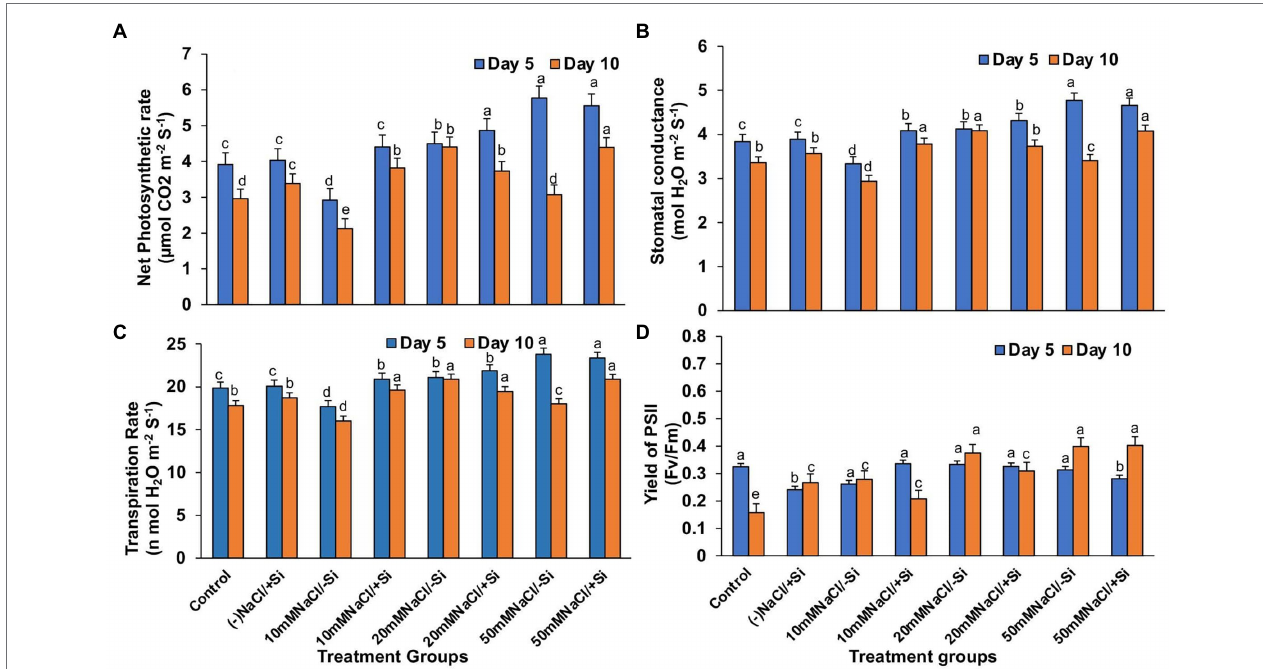
FIGURE 4 | Changes in (A) net photosynthesis, (B) stomatal conductance, (C) transpiration rate, and (D) PSII quantum yield of mung bean ( Vigna radiata ) under 1 mM (Si 1 ) Si supply and salinity stress after eight treatments: (i) control (T1), (ii) − NaCl+Si (1 mM) (T2), (iii) 10 mM NaCl/ − Si (T3), (iv) 10 mM NaCl/+ Si (1 mM) (T4), (v) 20 mM NaCl/ − Si (T5), (vi) 20 mM NaCl/+Si (1 mM) (T6), (vii) 50 mM NaCl/ − Si (T7), and (viii) 50 mM NaCl/+Si (1 mM) (T8) for a period of 5 and 10 days. Vertical bars indicate Mean ± SE of the means for n = 4. Means denoted by the different letters are significantly different at p ≤ 0.05 according to the Tukey’s studentized range